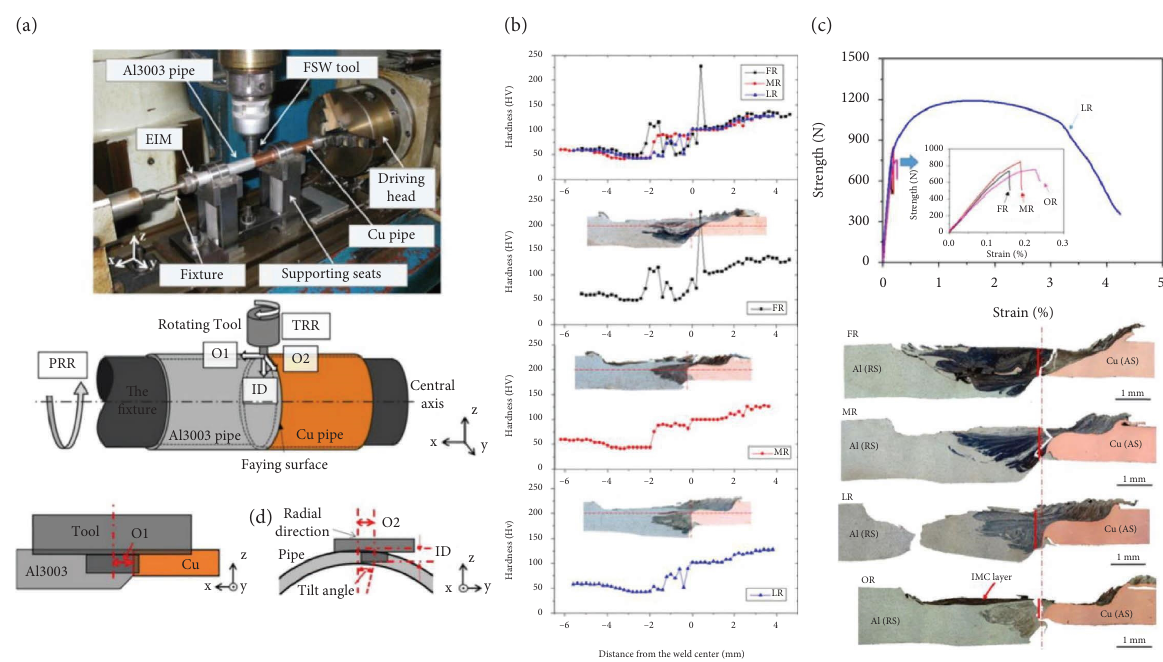
Figure 9: Te welding system: (a) the setting for pipe welding; a schematic diagram of the welding parameters showing O1 and O2. (b) Hardness distributions at the middle thickness along the horizontal dash lines in the cross-sections shown as insets for each region: overlap of all distributions; distribution for FR, MR, and LR. (c) Tensile curves of 4 regions; traverse cross-sections of fractured joints after tensile test showing two fracture modes. (PRS stands for pipe rotation rate; TRR for tool rotation rate; O1 stands for ofset1; O2 stands for ofset2; ID stands for insertion depth); FR: former region; MR: middle region; LR: later region; OR: overlap region.